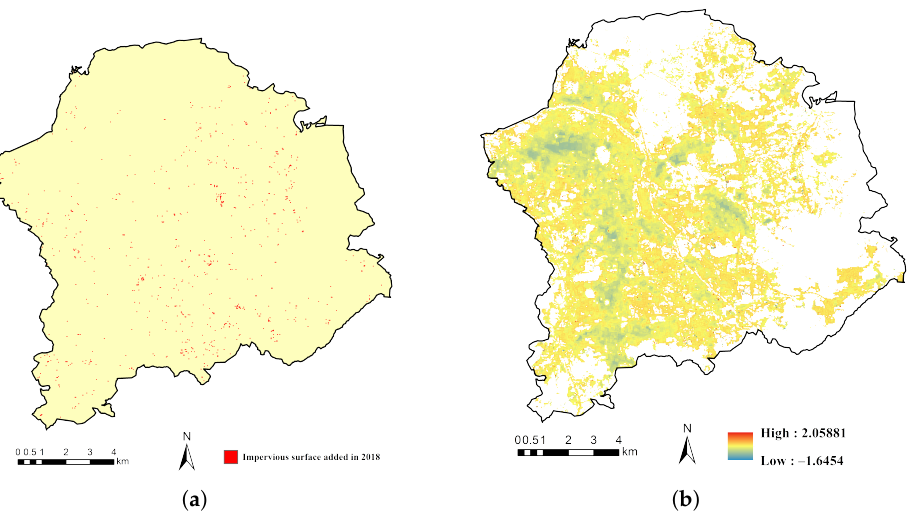
Figure 8. The actual increase in and forecast of artificial impervious area in Guangming District in 2018. ( a ) The actual increase in artificial impervious surface (2018). ( b ) The probability distribution of new impervious surface predicted by diffusion in Equation